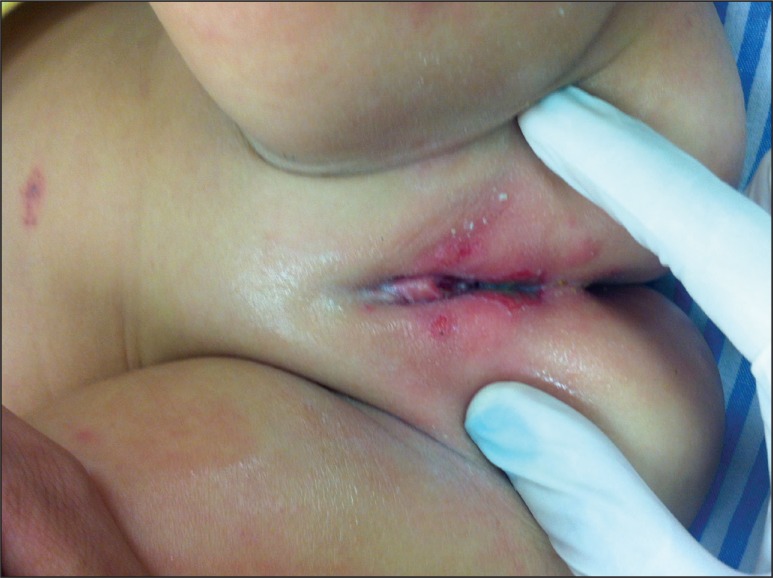
Queimadura na região vulvar, sendo possível identifi car a profundidade
das lesões e uma lesão em abdome